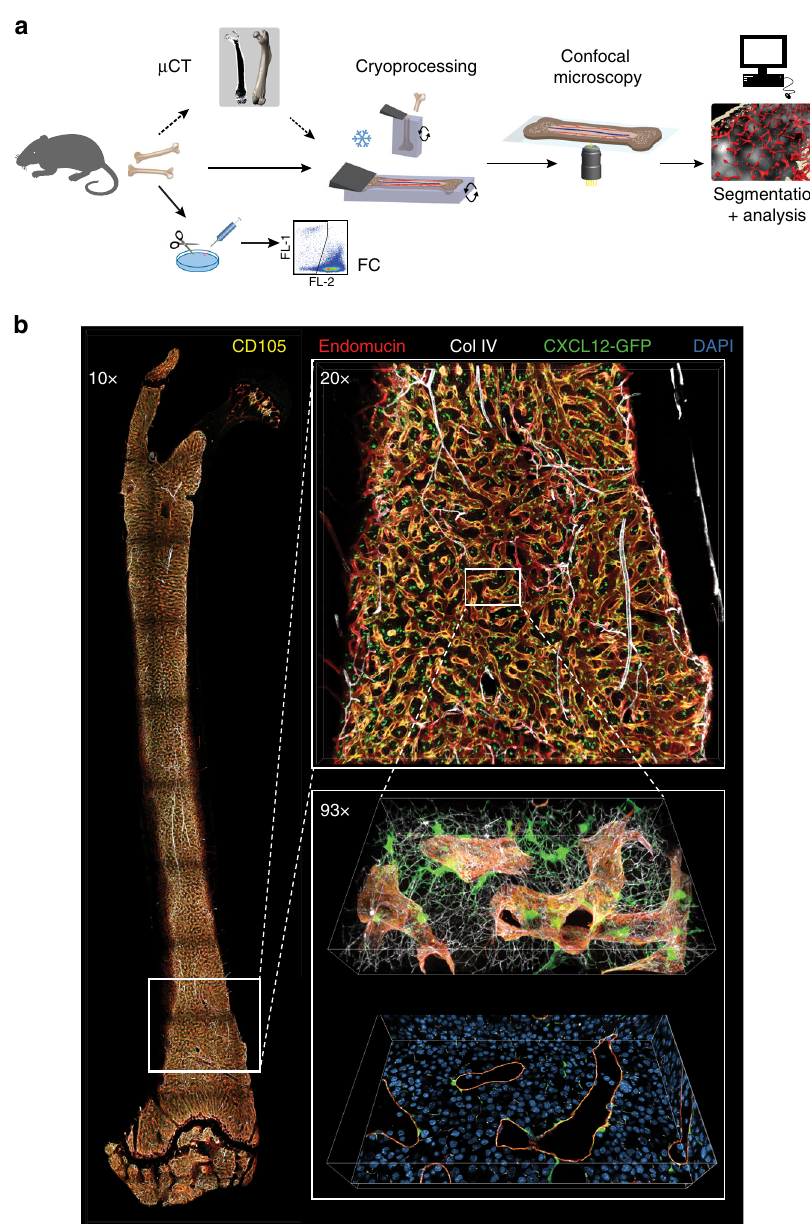
Fig. 1 3D quantitative microscopy (3D-QM) of murine BM femoral cavities. a Schematic representation of the experimental work fl ow for preparation, image acquisition and software-based analysis in multiscale imaging of BM tissues. For quanti fi cation of total BM volume, femurs are fi rst scanned by µ -CT and then cryopreserved and sectioned for subsequent confocal microscopy. The resulting 3D images are processed and analysed by 3D-QM to quantify mean cellular densities. Cell suspensions from contralateral femurs are prepared and analysed by fl ow cytometry (FC) when a pairwise comparison of data generated by both methodologies is required. b Examples of images acquired at different magni fi cations covering the entire femoral slice, to subcellular levels of resolution of an immunostained BM from a Cxcl12-Gfp transgenic mouse (10×, 20× and 93× magni fi cation). Lower image depicts a single optical section and an orthogonal slice of a confocal image stack in which dimensions in the z -axis and details on the nuclear staining with DAPI are visible. See also Supplementary Movie